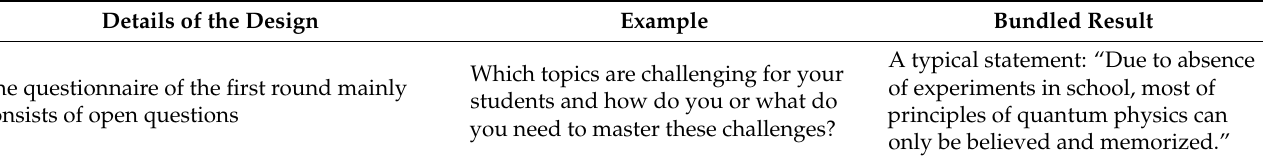
Table 2. Details of a Delphi